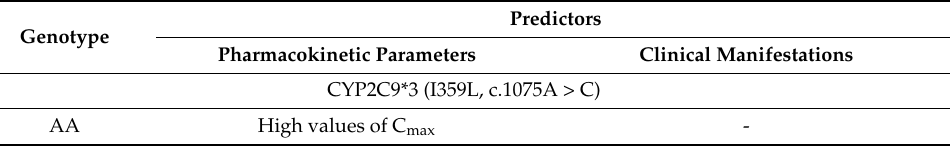
Table 19. The possible relationship between genetic factors, CPF pharmacokinetics and clinical manifestations of